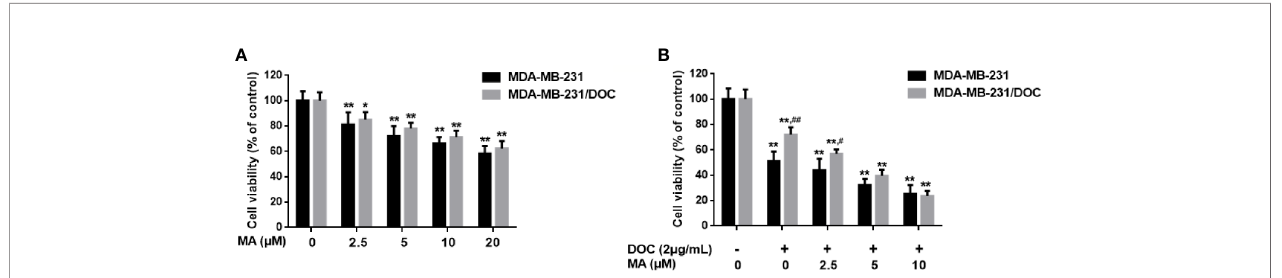
FIGURE 1 | The combined effect of docetaxel (DOC) and maslinic acid (MA) on cell viability in MDA-MB-231/DOC cells. (A) MDA-MB-231 and MDA-MB-231/DOC cells were incubated with MA alone for 24 h, and cell viability was evaluated by MTT assay. * p < 0.05 vs. control, ** p < 0.01 vs. control. (B) MDA-MB-231 and MDA- MB-231/DOC cells were incubated with DOC alone or DOC combined with MA for 24 h, and cell viability was evaluated by MTT assay. ** p < 0.01 vs. control, # p < 0.05, ## p < 0.01 vs. MDA-MB-231 group. All data were presented as means ± SD with three independent experiments, and triplicate repeats were included in each